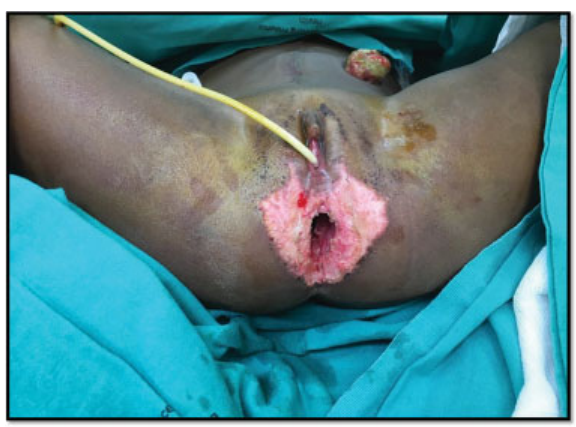
Fig.3 Contrast enema post hot-waterenemaadministrationshowing a rectal stricture with total cutoff at the sacral